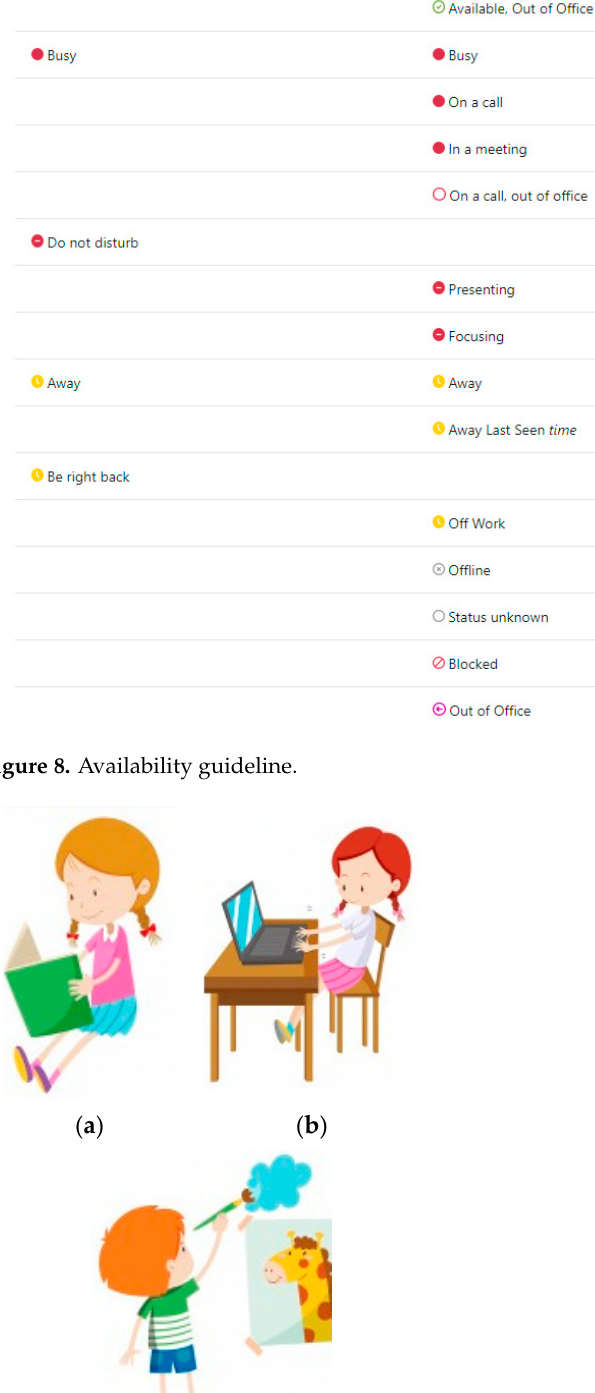
Figure 9. Activity guideline. ( a ) reading ( b ) typing ( c )